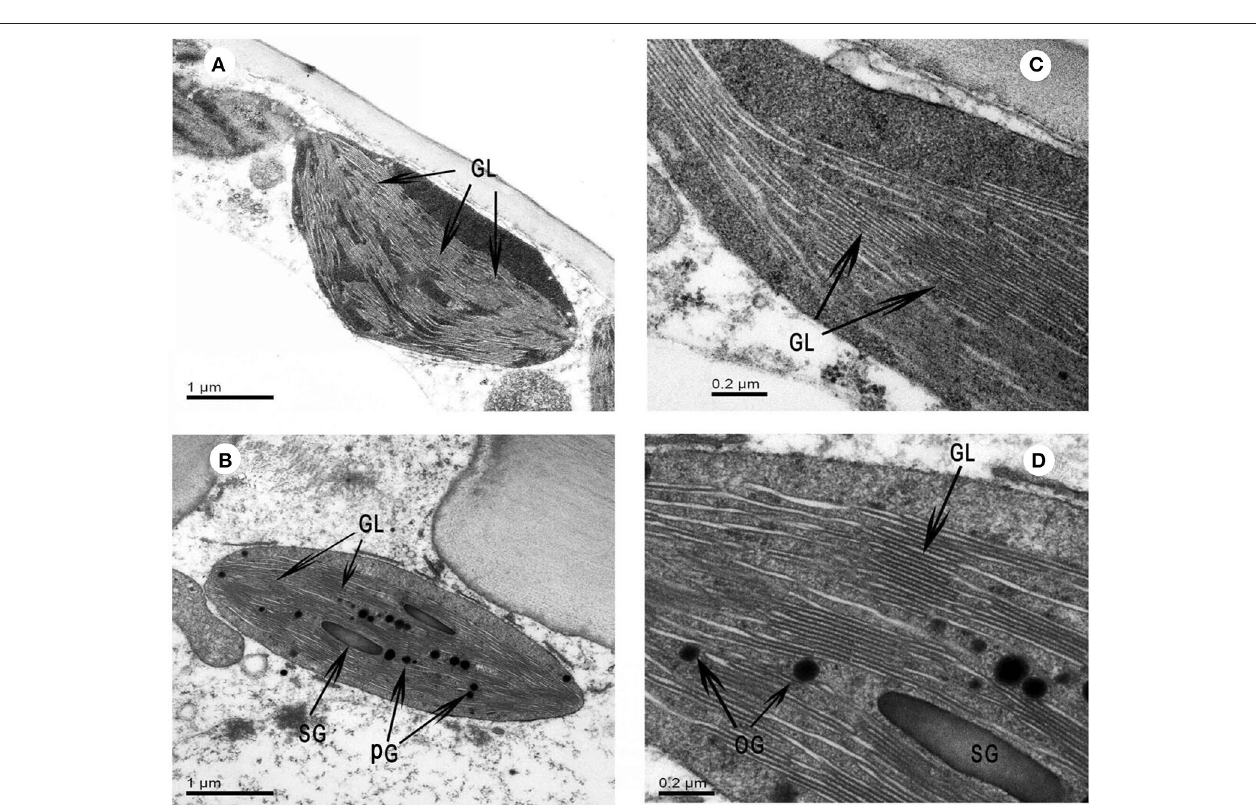
FIGURE 9 | The chloroplast ultrastructure in leaf (A,B) and sarcotesta (C,D) of Torreya grandis cv. “Merrillii.” The samples for microscopy were taken on 5th July in 2015, 81 days after seed protrusion (DASP = 81 days). PG, plastoglobuli; GL, grana lamellae; SG, starch grains.